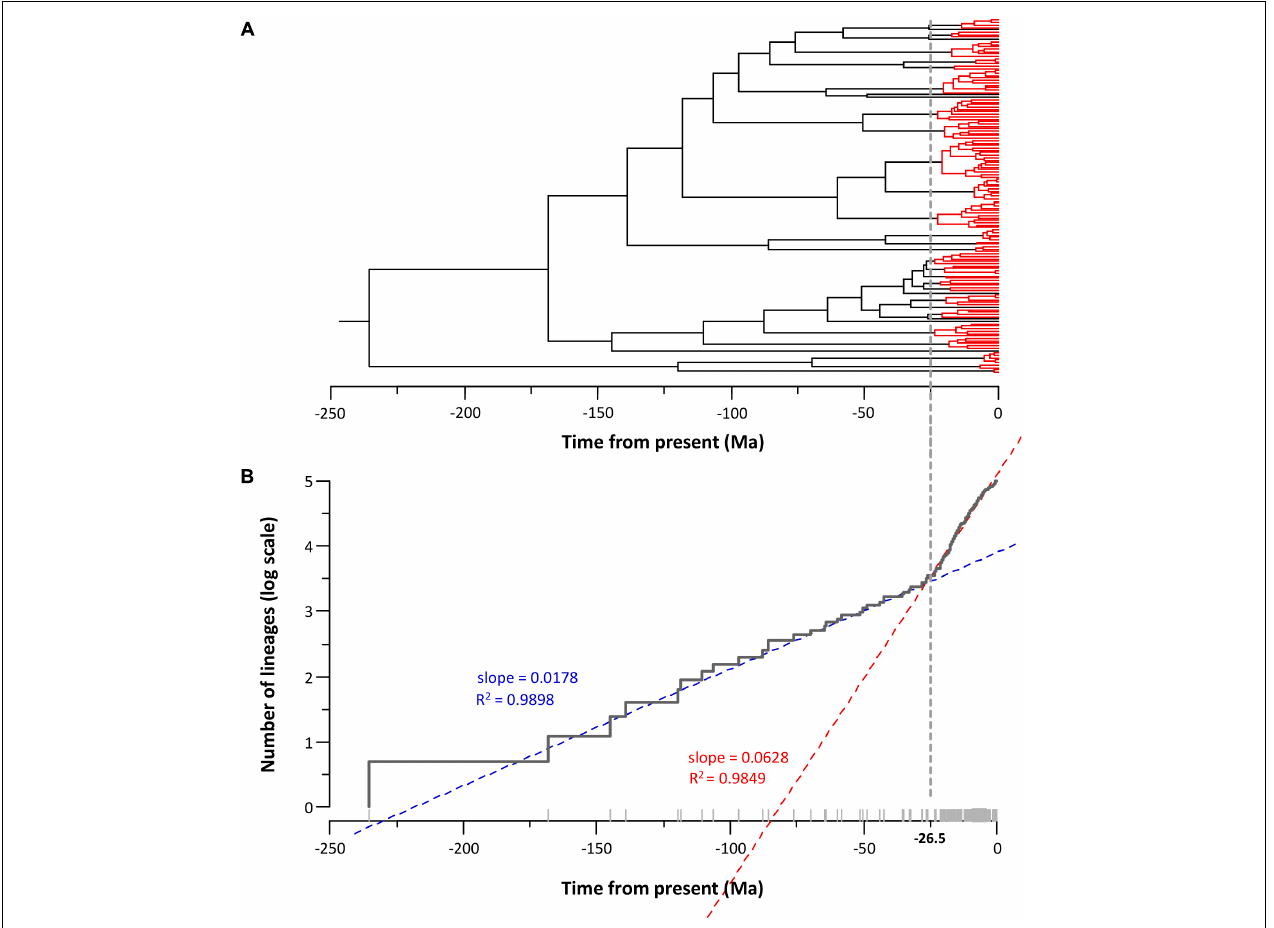
FIGURE 5 | Aeromonas diversification. (A) Aeromonas chronogram showing the temporal node distribution. Nodes posterior to –25 Ma (breakpoint) are marked in red. (B) LTT plot corresponding to the chronogram showing the breakpoint and the linear adjustment of the two segments (before and after the